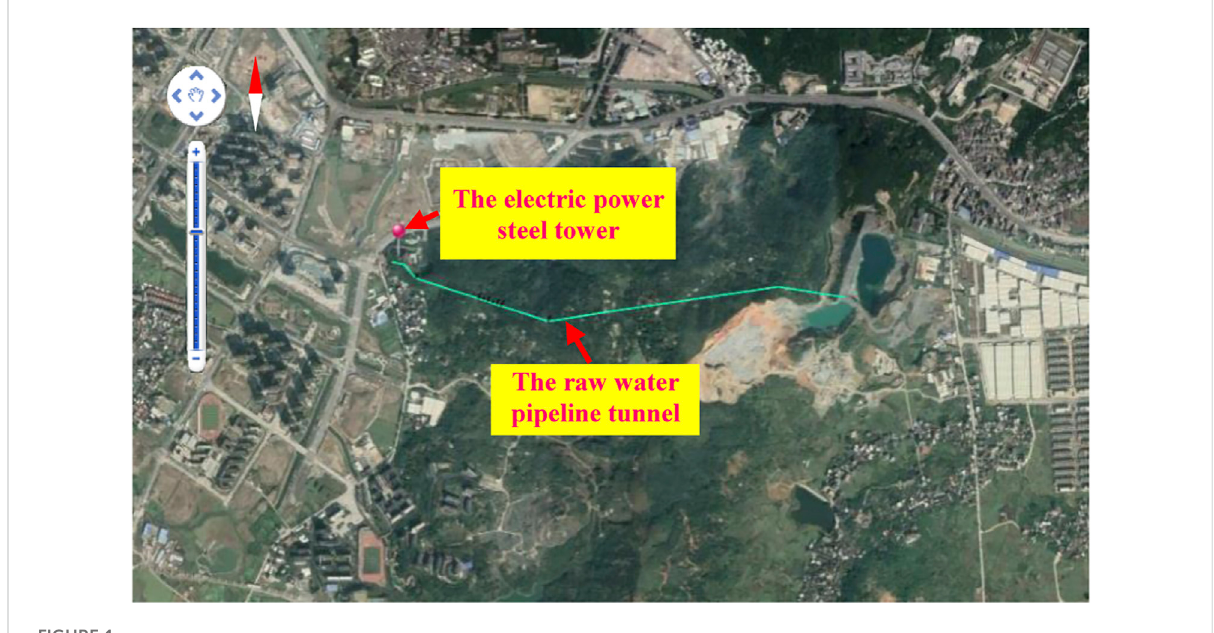
FIGURE 1 Plane location map of the raw water pipeline